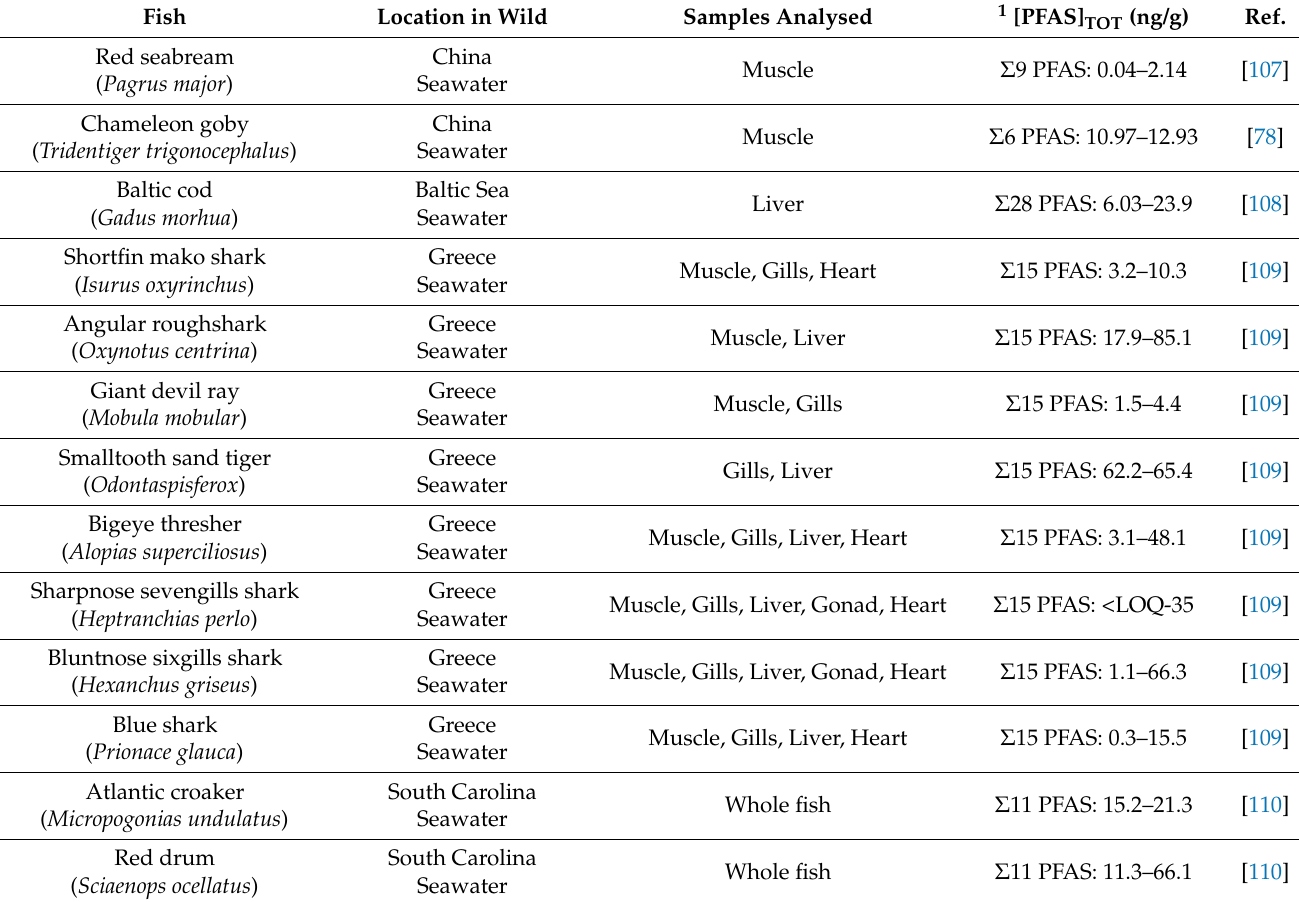
Table 1. Number of monitored PFCs (PFAS) and their total concentration as a function of investigated species in different locations in wild